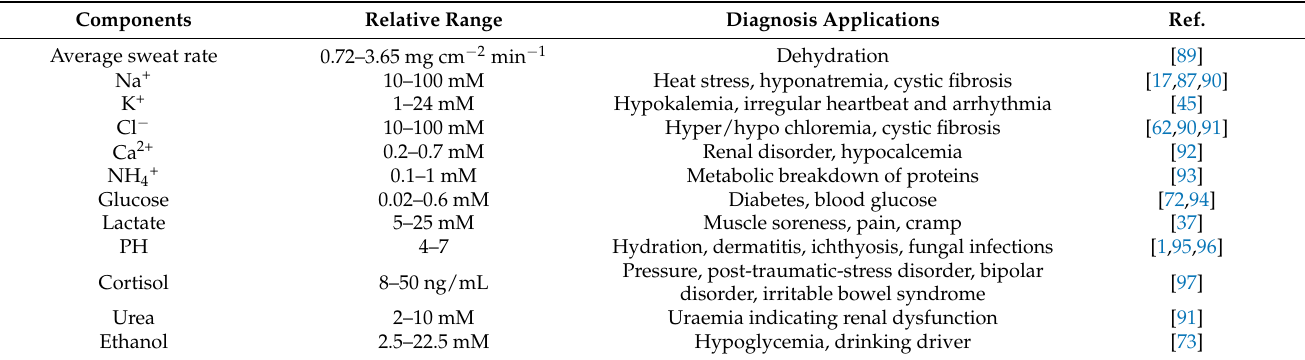
Table 2. Common components of sweat and their associated diagnosis